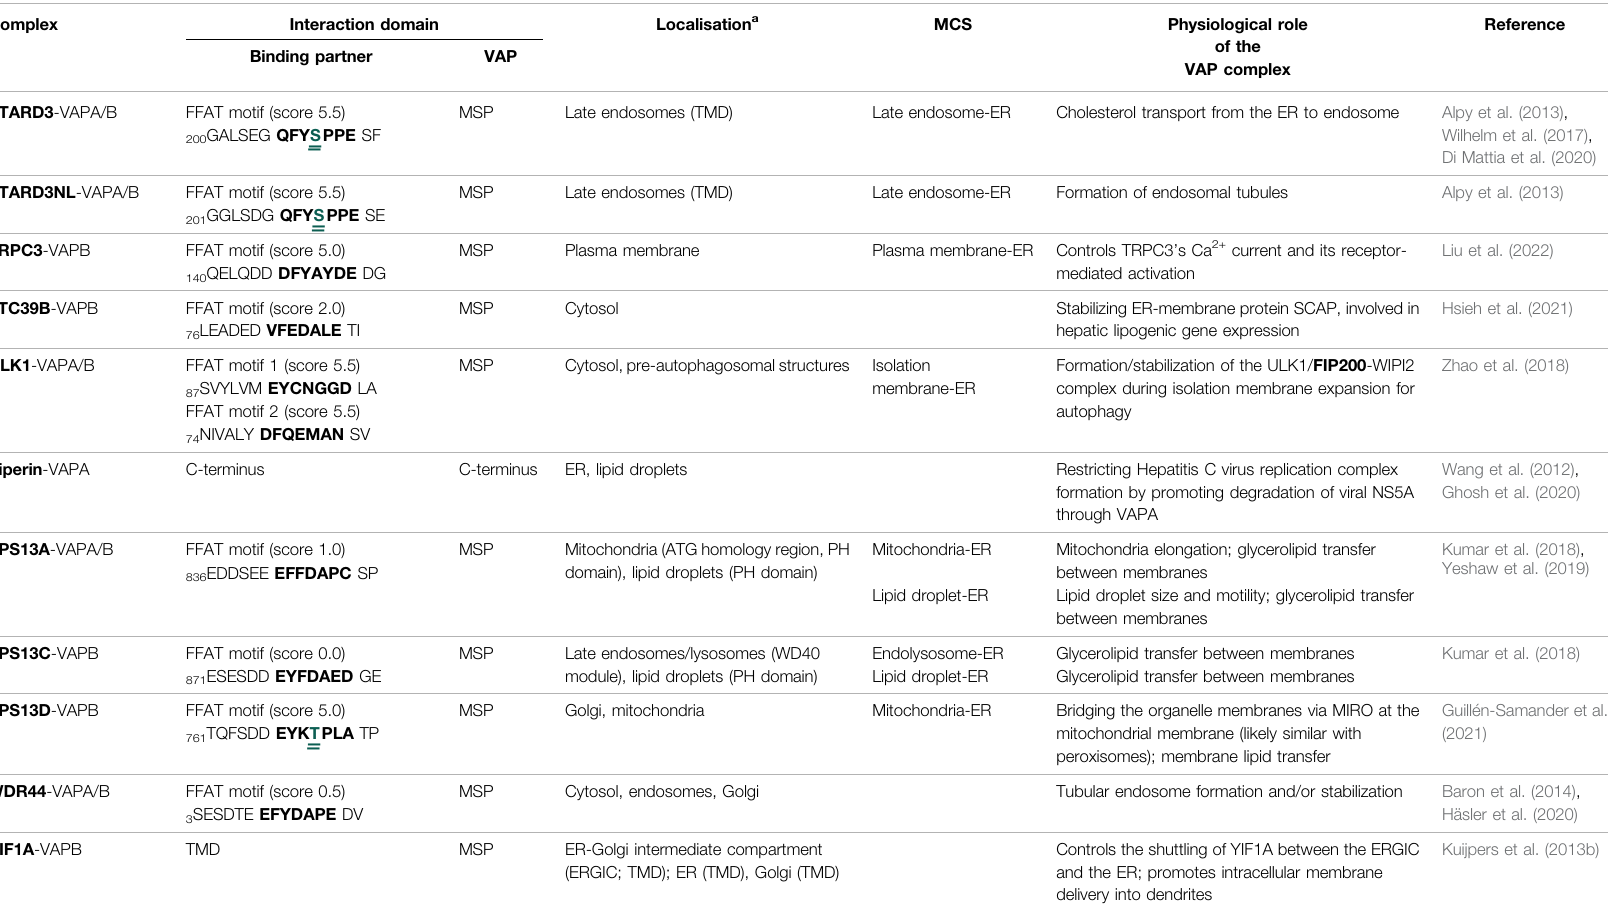
TABLE 1 | ( Continued ) An overview of experimentally con fi rmed VAP binding partners in mammalian cells.